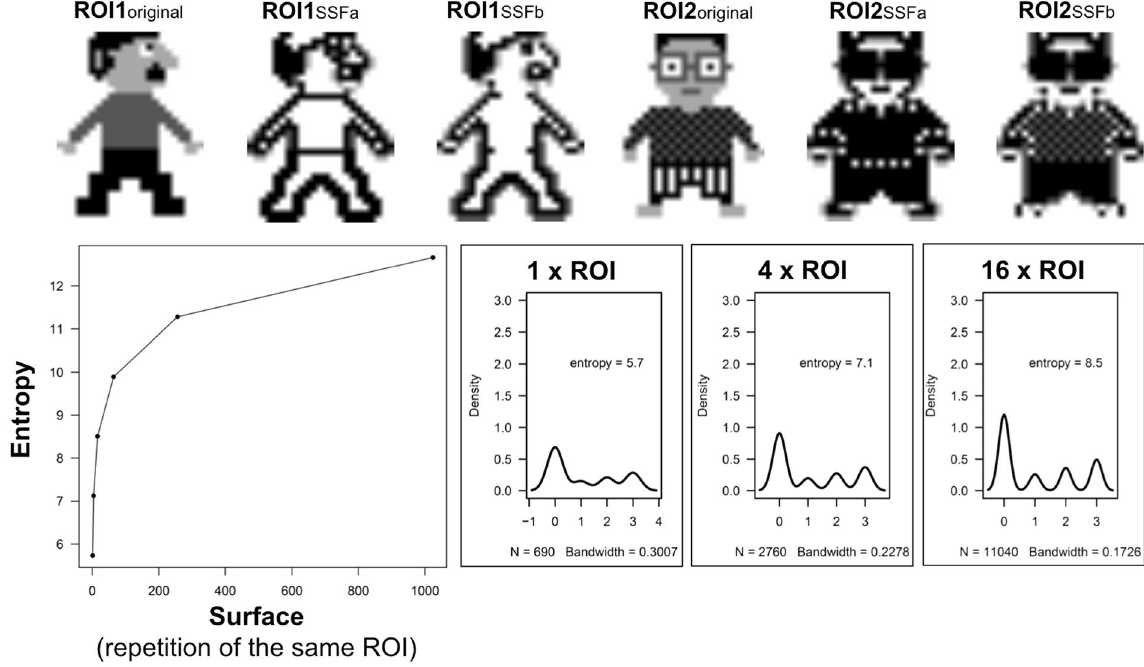
Figure 4. Mathematical model evaluating the evolution of Entropy in function of the surface of the ROI and the impact of SSF. We calculated the entropy in function of the surface of the ROI. We defined the surface by the number of repetitions of the same 690 pixel ROI (i.e. ROI1 original and ROI2 original ). ROI1 original and ROI2 original have the same distribution of pixel intensity coded 0, 1, 2, and 3 and are associated with a corresponding white - grey - black signal intensity. It shows that (i) entropy is identical in very different ROIs, and (ii) entropy calculated after Laplacian of Gaussian filtering (SSFa and b such as used by TexRAD) remains area dependent although it captures a different pixel spatial distribution between ROI1 and